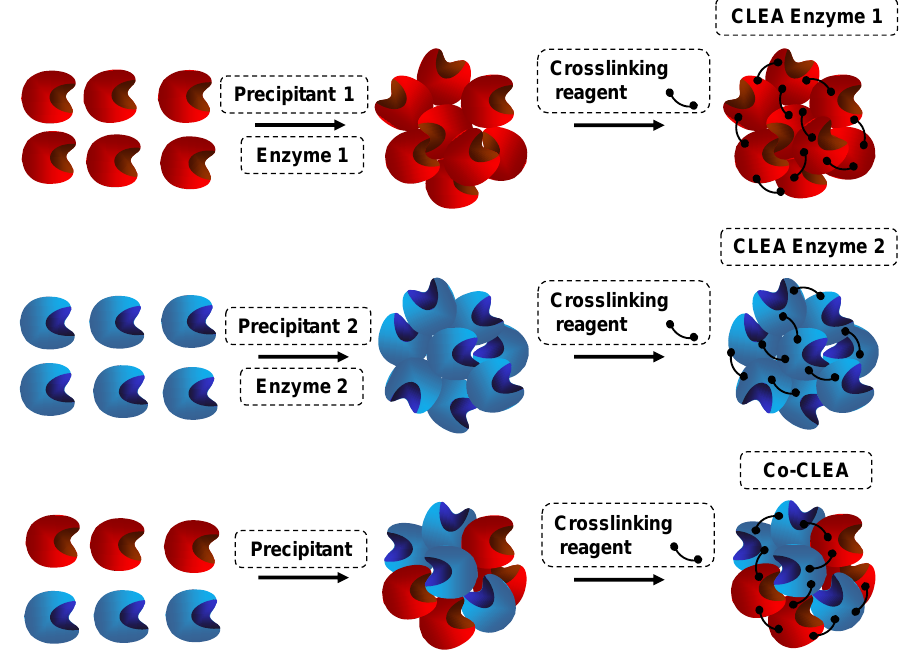
Figure 21. Individual immobilization or coimmobilization of enzymes using crosslinking enzyme aggregates technology (CLEA).